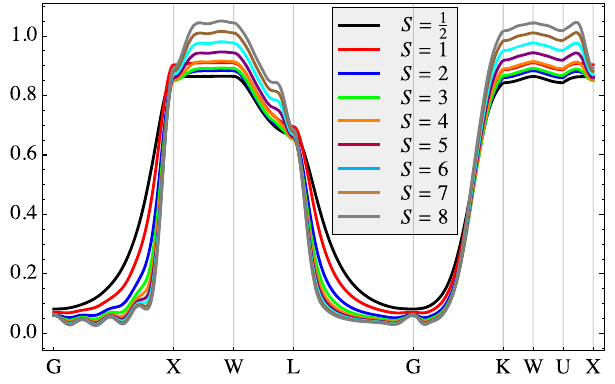
FIG. 14. The susceptibility of the isotropic nearest-neighbor Heisenberg antiferromagnet plotted along the high-symmetry path evaluated at the lowest simulated temperature ( T=J 1 ¼ 1 = 100 ) for S ¼ 1 = 2 and S ¼ 1 and at the critical breakdown temperature ( T c ) (marked by arrows) in the RG flows in Fig. 13 for S > 1 .